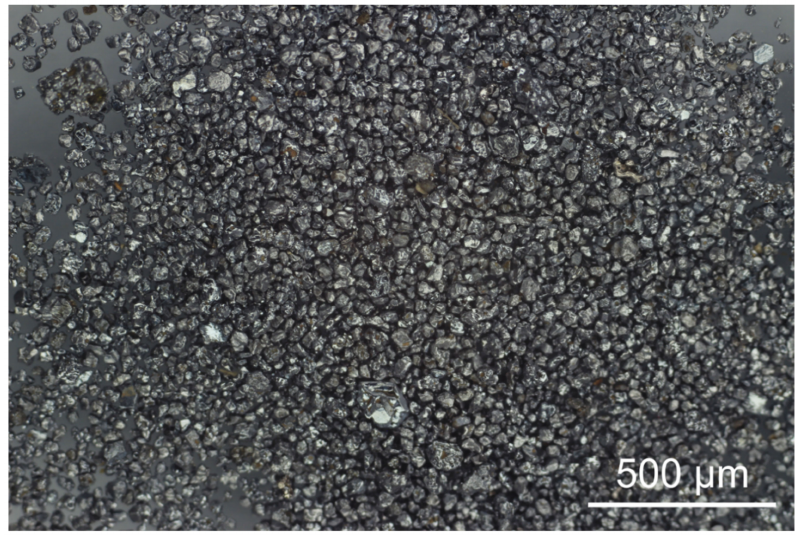
Figure 5. PGM concentrate from the Gule River placer (photo by B. Lobastov).